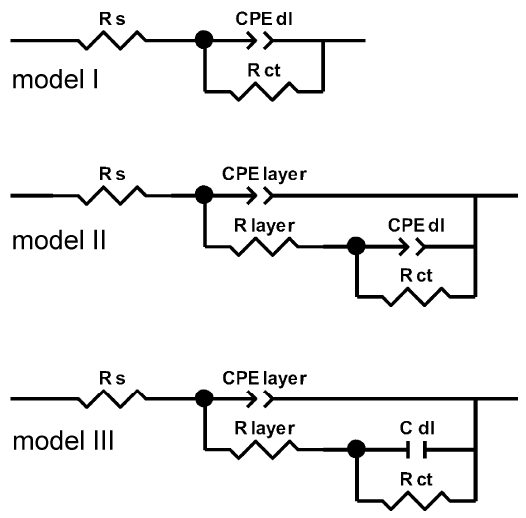
Figure 10. Electric equivalent circuits for the corrosion of Ni coatings.